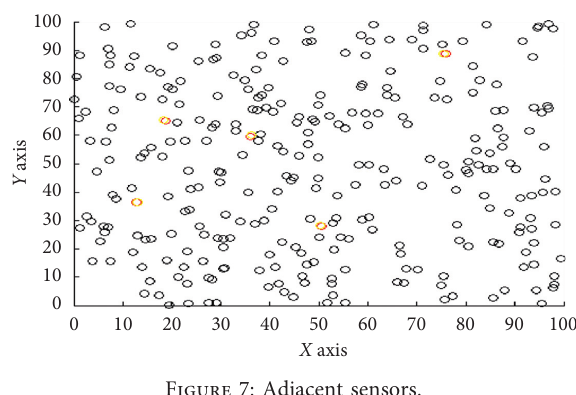
Figure 7: Adjacent sensors.